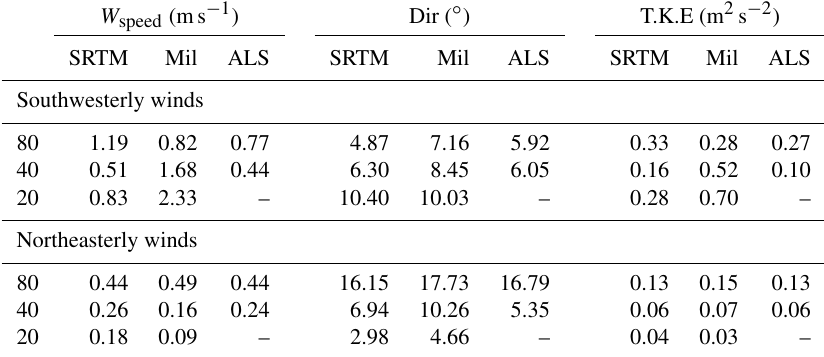
Table 9. RMSE of wind speed, wind direction and turbulent kinetic energy for tower